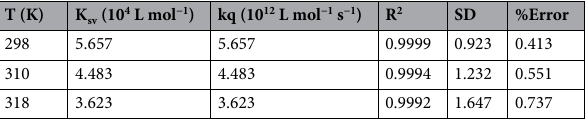
Table 1. MBZ-BSA interaction parameters at various temperatures.